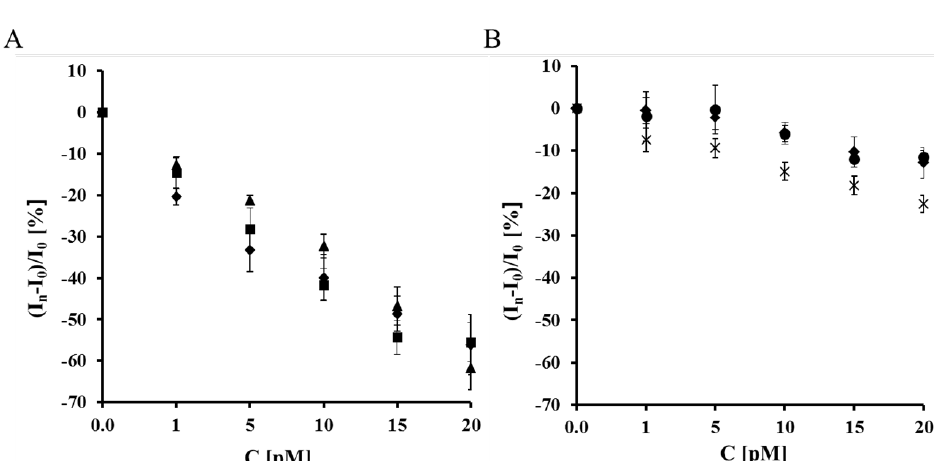
Figure 5. The relationship of relative Cu(II) redox current decrease vs. concentration of S100B measured with electrodes: ( A ) (▲) Au/NAC/DPTA–Cu(II)–His natural domain in TRIS buffer in the presence of Ca 2+ ; (♦) Au/NAC/DPTA–Cu(II)–His RAGE VC1 natural domain in diluted human plasma in the presence of Ca 2+ ; (■) Au/NAC/IDA–Cu(II)–His –RAGE VC1 natural domain in TRIS buffer with 10 nM 6 Aβ in the presence of Ca 2+ . ( B ) (●) Au/NAC/DPTA–Cu(II)–His 1-40 TRIS buffer in the presence of Ca 2+ ; ( × ) Au/NAC/DPTA–Cu(II)–His domain in TRIS buffer in the presence of Ca 2+ ; (♦) Au/NAC/IDA–Cu(II)–His VC1 natural domain in TRIS buffer without Ca 2+ .